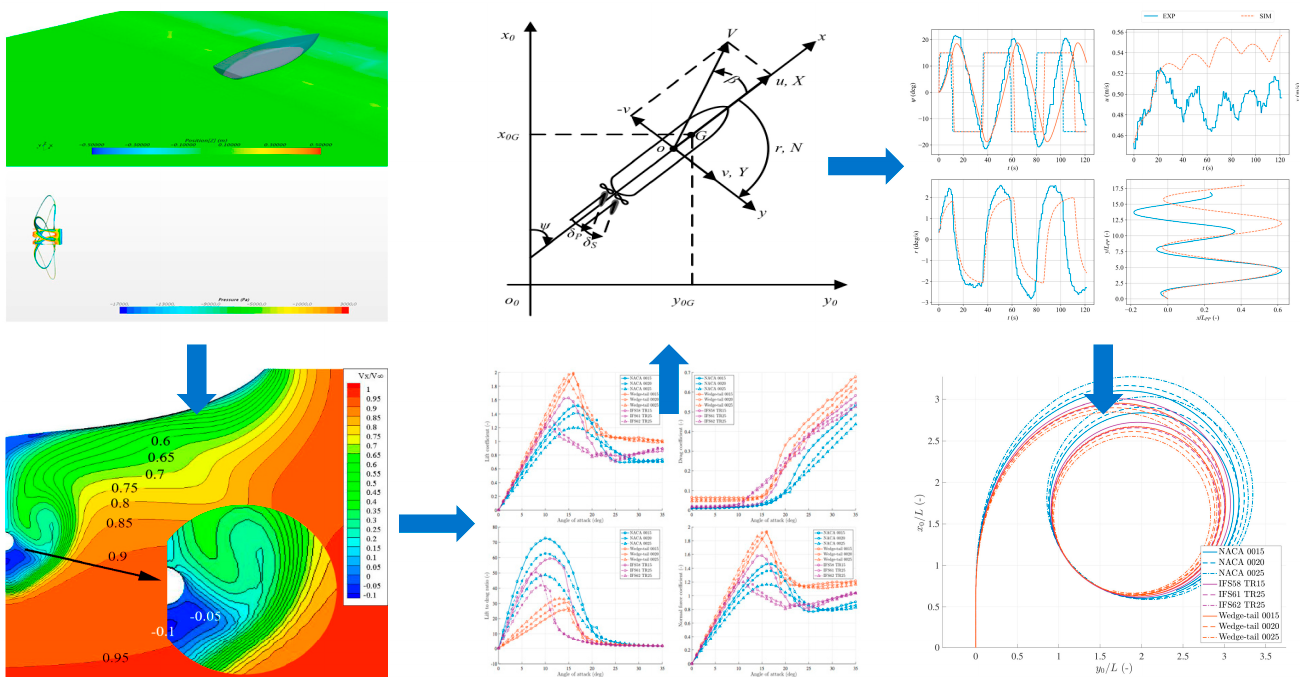
Figure 1. Ship Maneuvering Model.